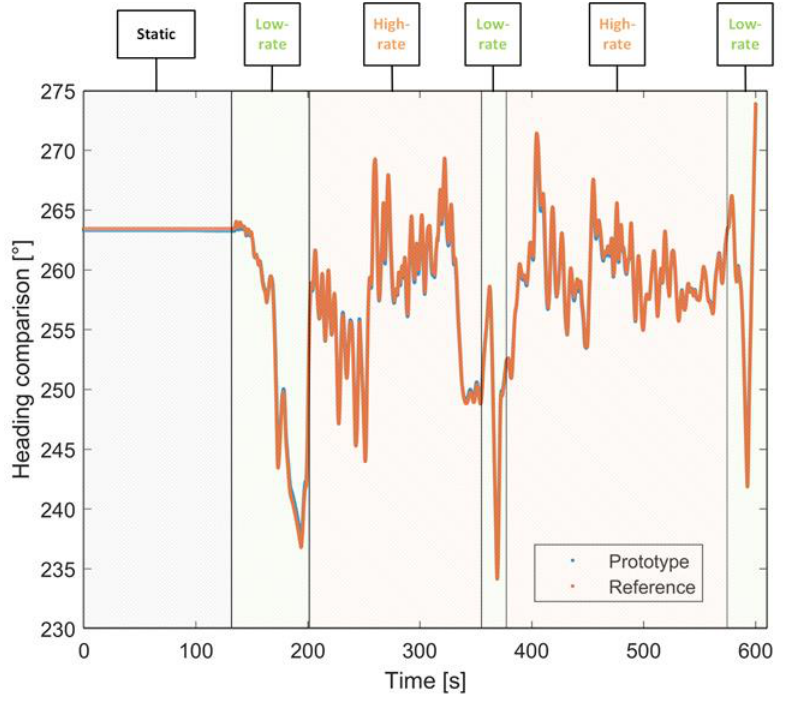
Figure 12. Heading angle comparison in tests conducted in dynamic conditions. Table 6. Results of the comparison tests under standing conditions expressed in terms of the differ- ences between the measured and reference angles.